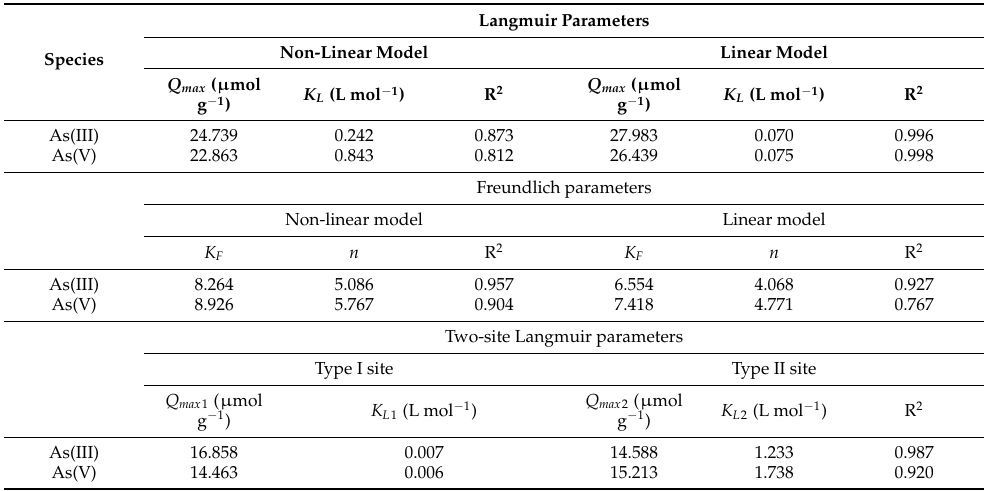
Table 1. Isotherm parameters obtained for non-linear and linear Langmuir and Freundlich models and for the two-site Langmuir model for the adsorption of As(III) and As(V) onto Bi 2 O 3 . Langmuir Parameters Non-Linear Model Linear Species